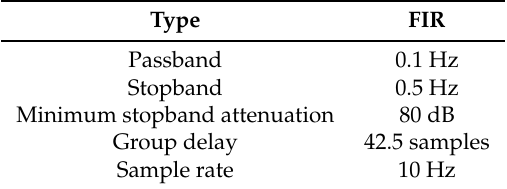
Table 1. Finite impulse response (FIR) Lowpass filter